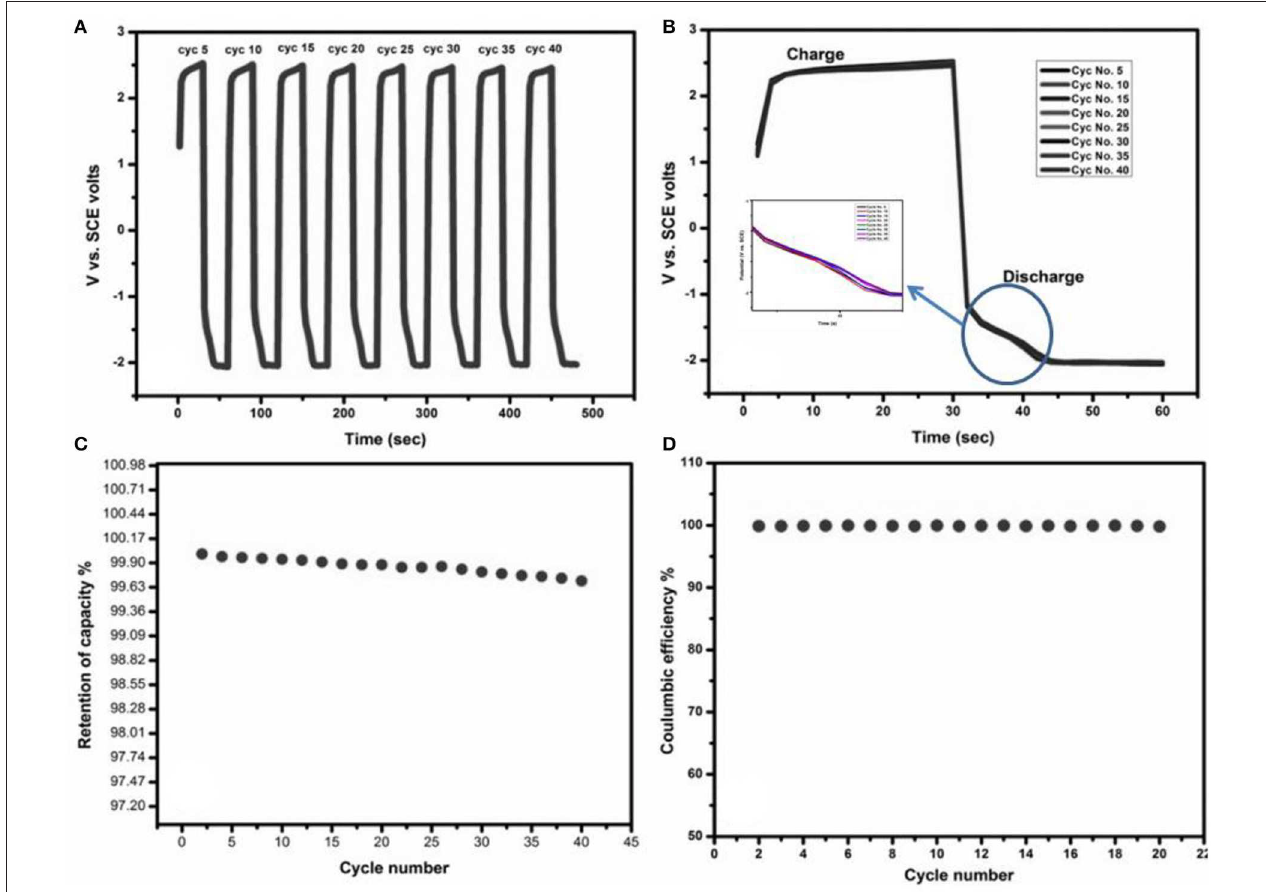
FIGURE 7 | EIS spectrum for SnS electrode, inset shows the magnified view of lower value of Z real and Z img .